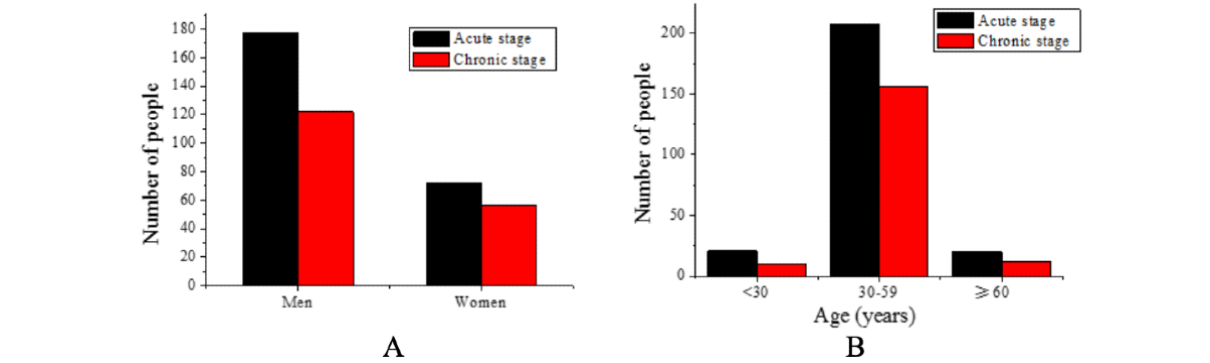
Figure 3. The number of people with brucellosis in different stages by gender (A) and age